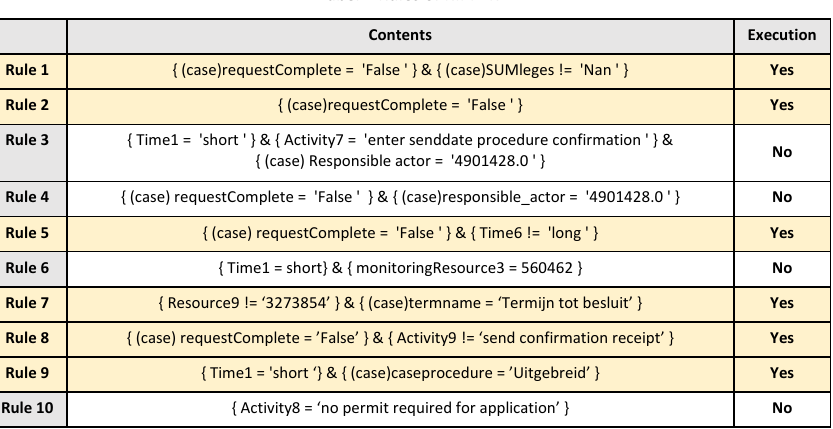
Figure 6. Example of local-level model visualisation (a trace of the BPIC 2015 event log at prefix